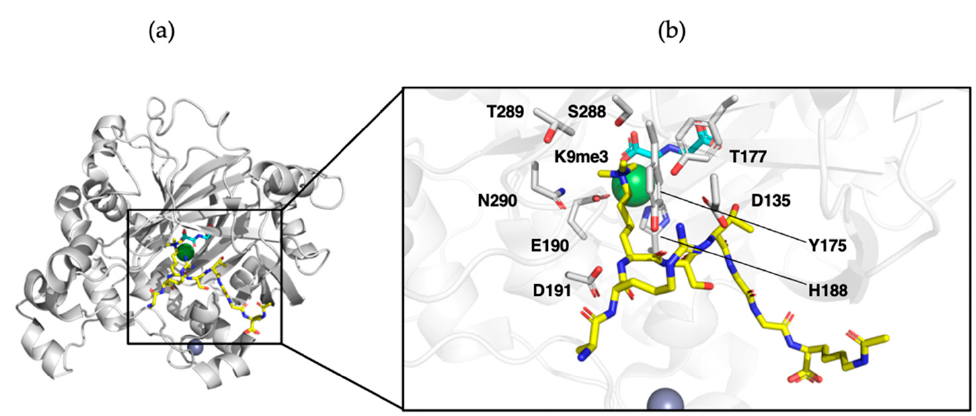
Figure 12. ( a ) Ribbon representation of JMJD2A (grey) in complex with H3K9me3 (yellow), Ni(II) (dark gray), Zn(II) (green), and NOG (cyan) in stick representation. ( b ) A zoomed view on the JMJD2A H3 binding site. All key JMJD2A residues are labeled [110].